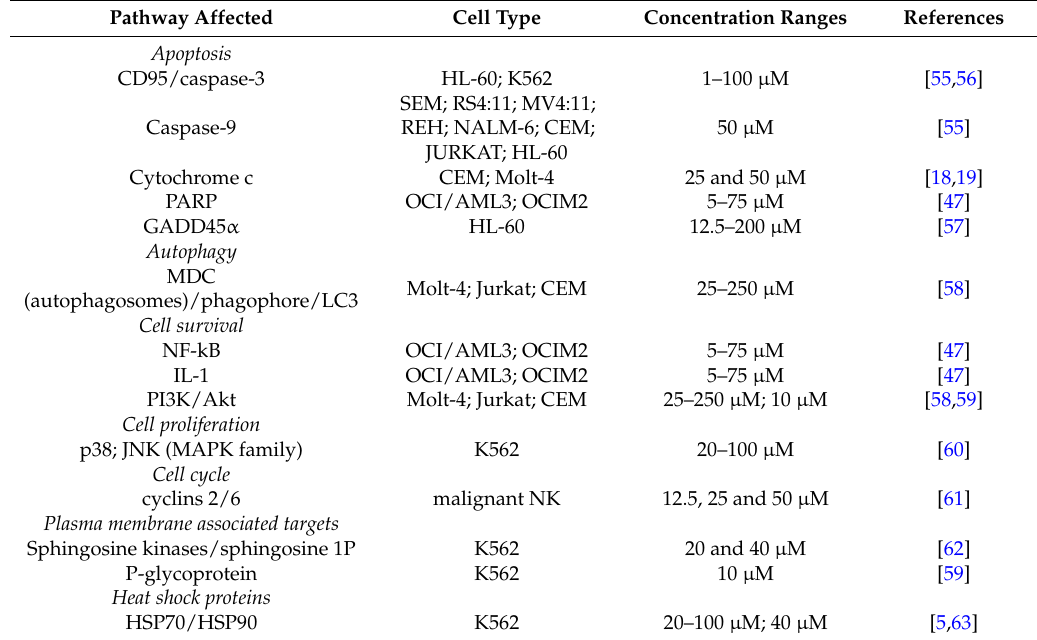
Table 2. Summary of the leukemia molecular targets cited in the